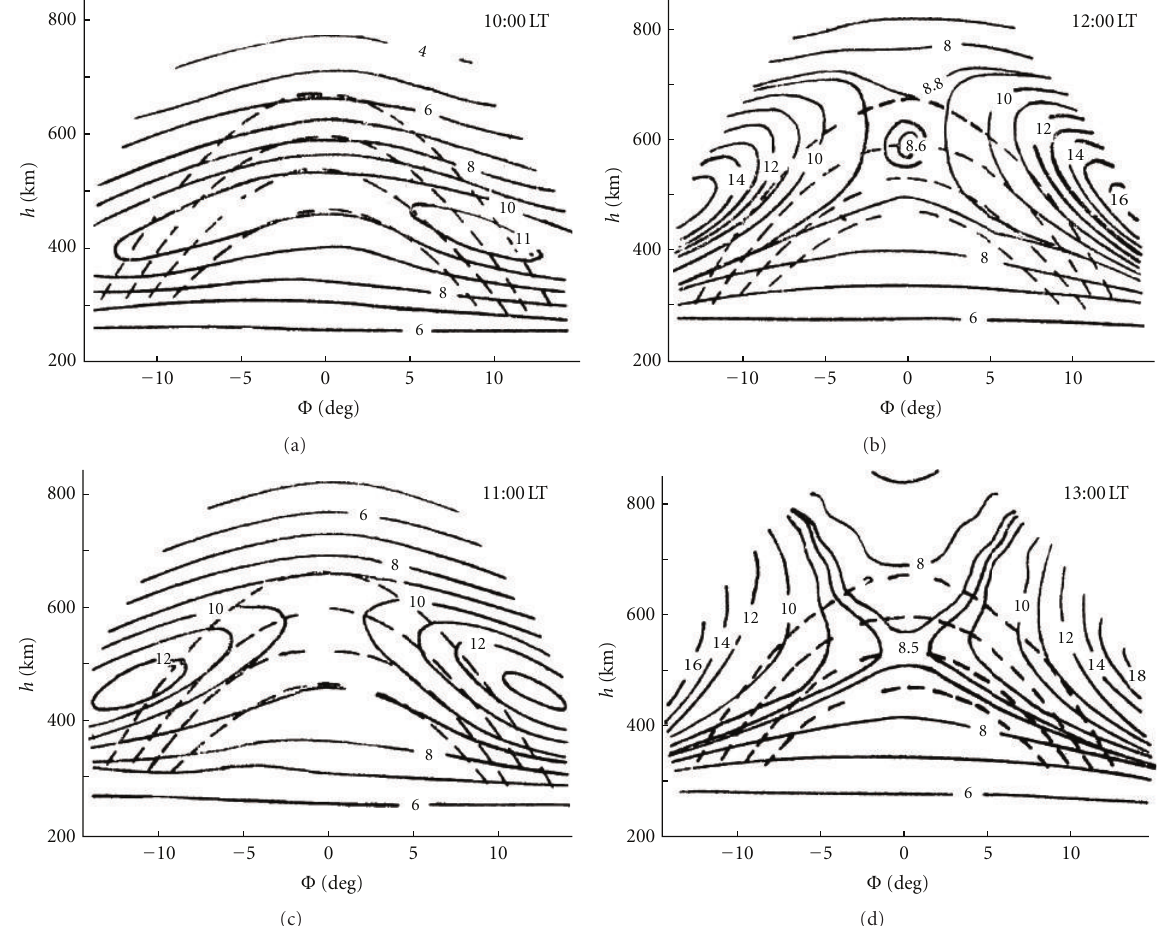
Figure 9: Latitudinal profiles of the plasma frequency isolines at 10:00, 11:00, 12:00, 13:00 LT for the geomagnetic latitude of station Jica- marca, calculated using a numerical model of the equatorial ionosphere (from Surotkin et al. [31]). The dashed lines show the geomagnetic field lines.